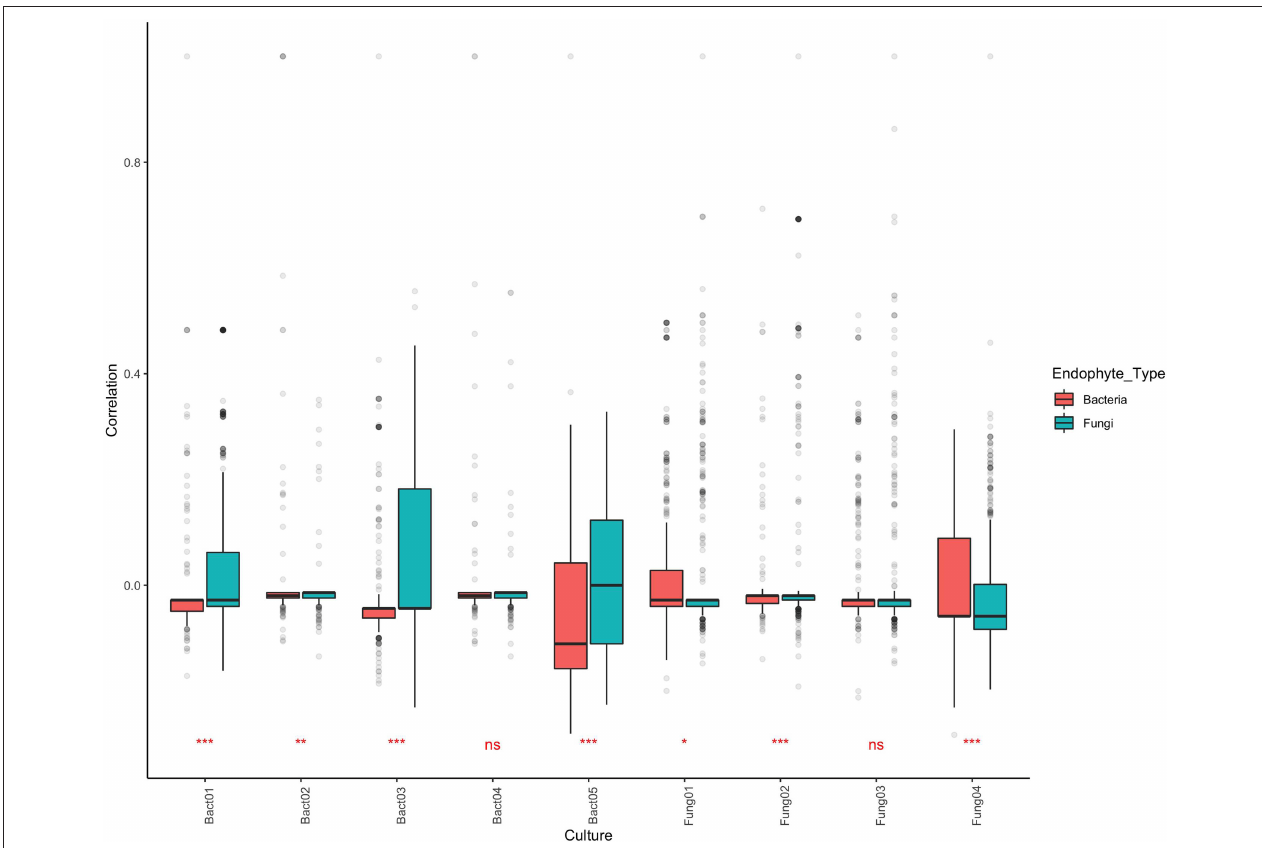
FIGURE 6 | Community co-occurrence correlation values for nine endophytes which demonstrated antipathogen activity when cultured corresponding to OTUs in the metabarcoding dataset. Values of 1 indicate consistent co-occurrence and − 1 indicate OTUs never co-occurring. Significance values shown indicate whether community co-occurrence correlation values for the bacteria differ from those of